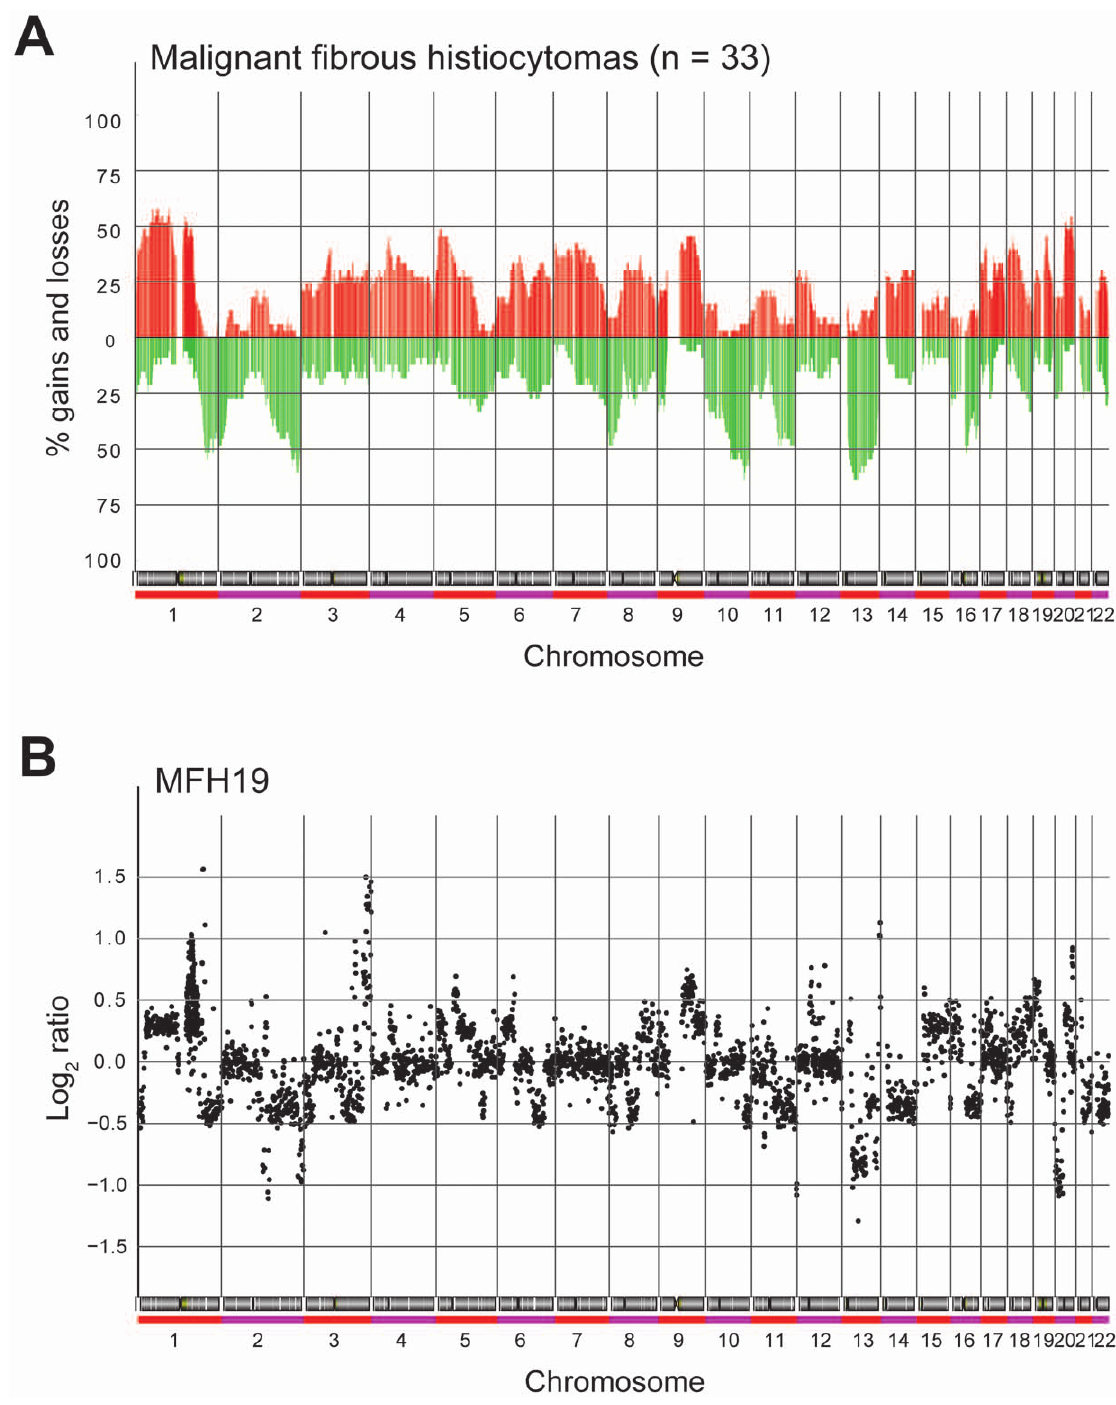
Figure 2. DNA copy number alterations. ( A ) Genome-wide frequency plot of copy number alterations identified by ACE in 33 MFHs. Red, increases in DNA copy number; green, decreases in DNA copy number. ( B ) Whole genome DNA copy number profile of a representative MFH. Log 2 ratio for each of the genomic clones is plotted according to chromosome position.